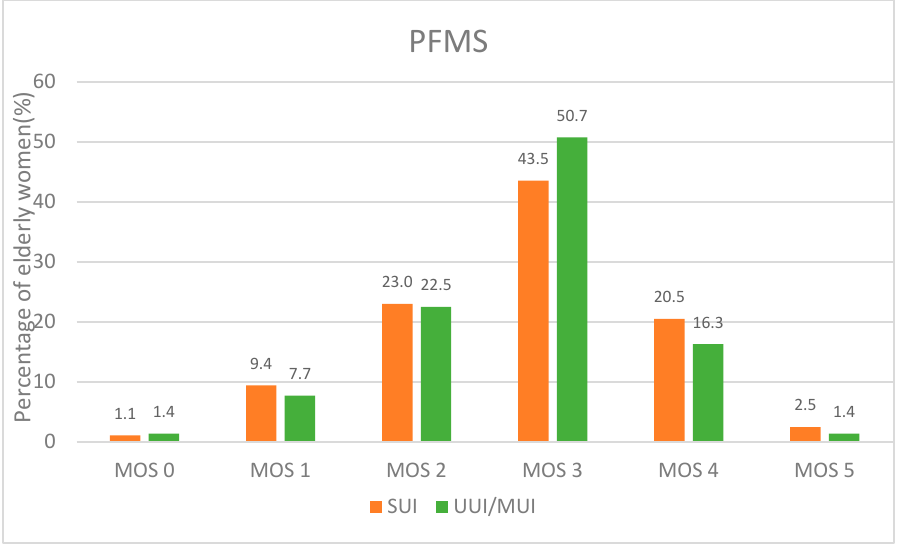
Figure 2. PFMS scores by MOS for the participants.